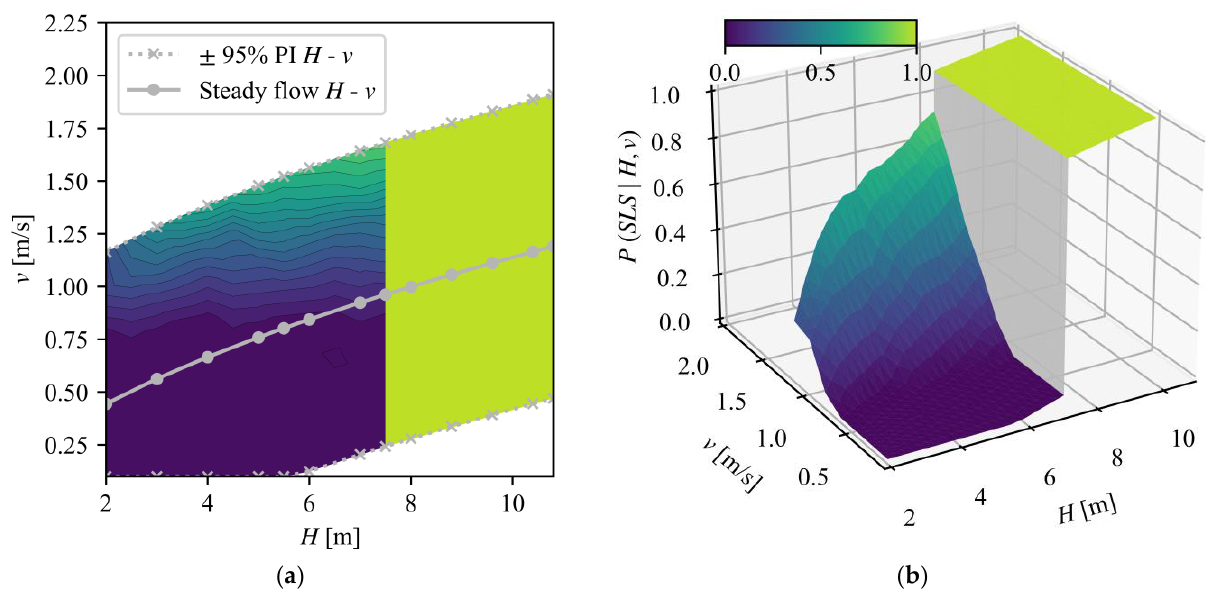
Figure 10. ( a ) Contour and ( b ) 3-D surface plot of the flood fragility surface for the serviceability limit state (SLS) for the third scenario (Panici and Almeida’s model [48]).